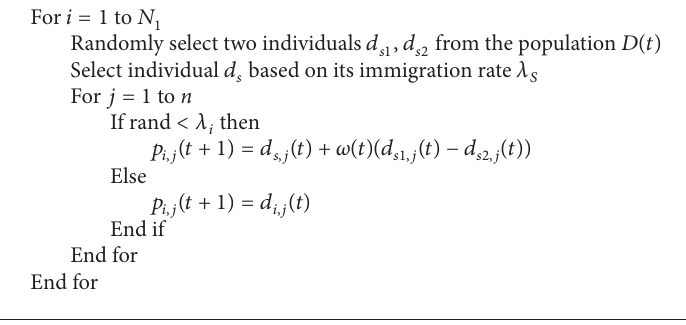
Algorithm 2: Disturbance migration operator 𝑇 𝑖